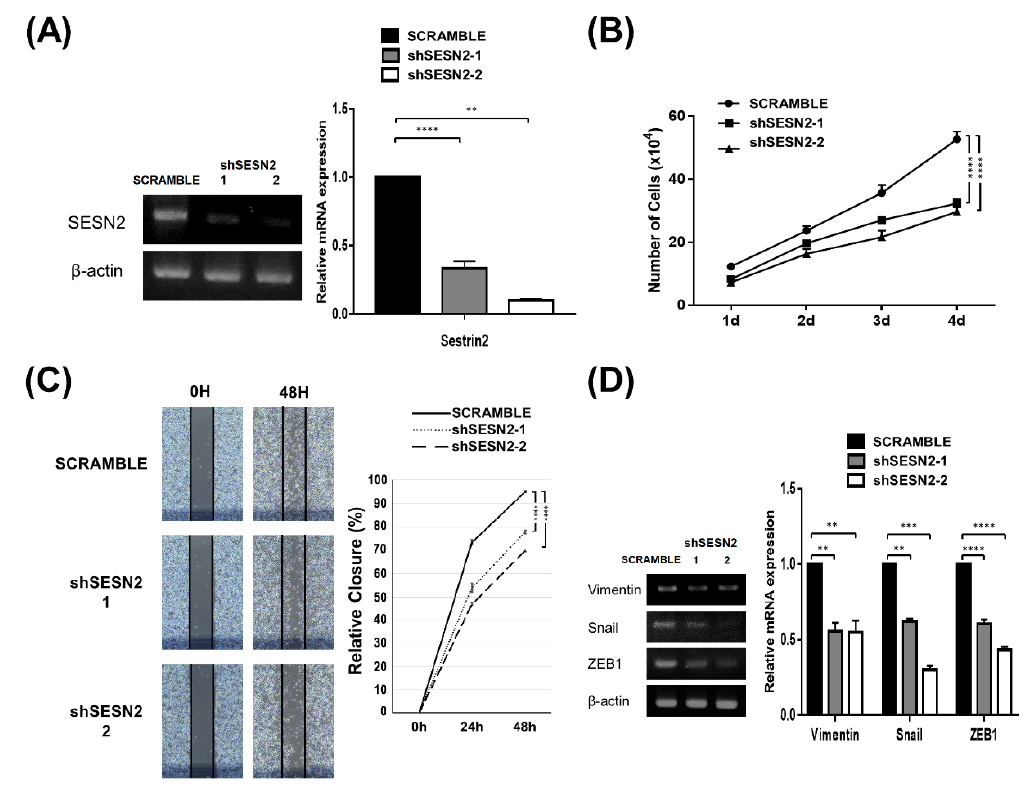
Figure 1. Survival and migration were decreased in response to Sestrin2 knockdown in A549 lung cancer cells. ( A ) Expression of Sestrin2 in shSESN2-1, shSESN2-2, and scramble A549 cells as measured by RT-PCR followed by subsequent agarose gel analysis. Band density was measured with ImageJ and is plotted as the value relative to scramble control. ( B ) Survival of scramble, shSESN2-1, and shSESN2-2 cells was measured using trypan blue staining. The number of cells was counted using a hemocytometer. ( C ) The wound healing assay revealed cell movement capacity. Cells were observed at the indicated time, and closure percentage is plotted. The photo was taken under an inverted light microscope and closure percentage was measured using ImageJ. ( D ) The mRNA expression of epithelial–mesenchymal transition markers (Vimentin, Snail, ZEB1) was downregulated in Sestrin2 knockdown cells compared to that in scramble cells. Band density was measured using ImageJ and is plotted on the right (** p < 0.01; *** p < 0.005; **** p < 0.0001).